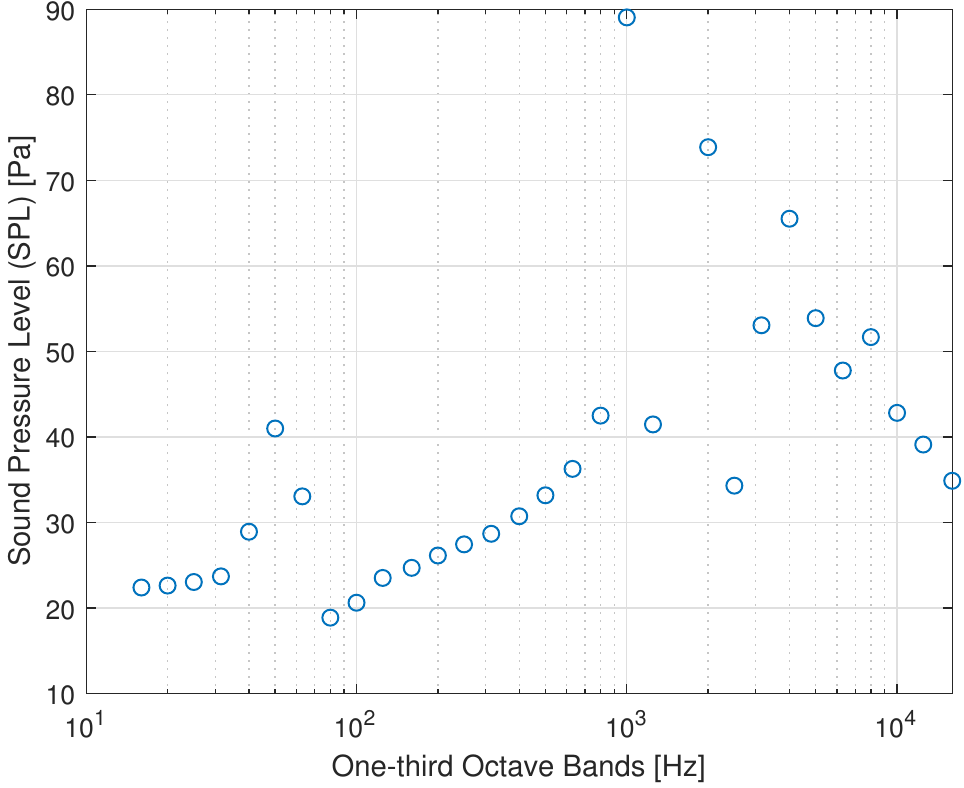
Figure 20. Morphed airfoil total noise one-third octave bands at azimuthal angle of 90 ◦